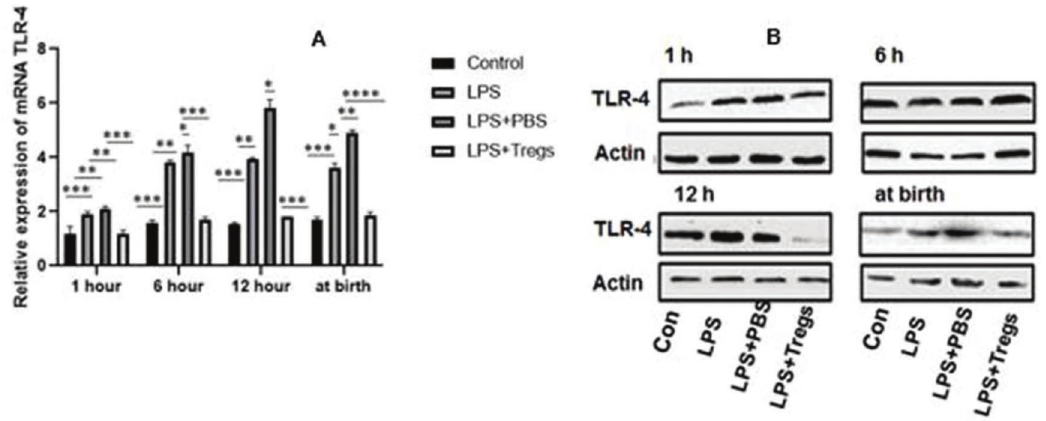
Figure 4 - (A) After different treatments in liver tissues, the TLR-4 was statistically measured and examined by qRT-PCR. The significant difference among groups were * p o 0.05, ** p o 0.01 and *** p o 0.0001. (B) In different time levels, mRNA expression was decreased after the transmission of Treg cells by western